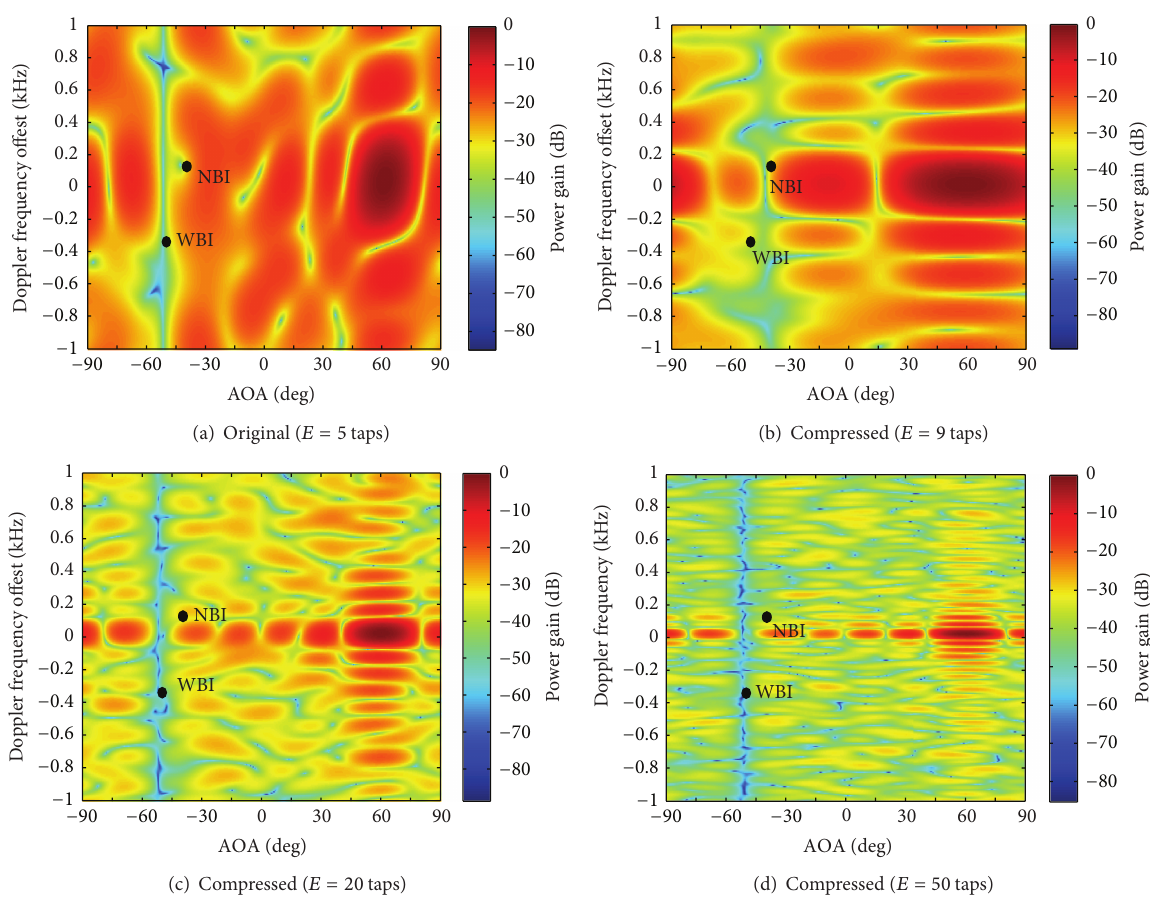
Figure 3: The angle-frequency spectrum with and without compression measurement ( 𝐾 󸀠 /𝐾 = 0.7 ); (a) without compression measurement; (b) with compression measurement under 9 delay taps; (c) with compression measurement under 20 delay taps; (d) with compression measurement under 50 delay